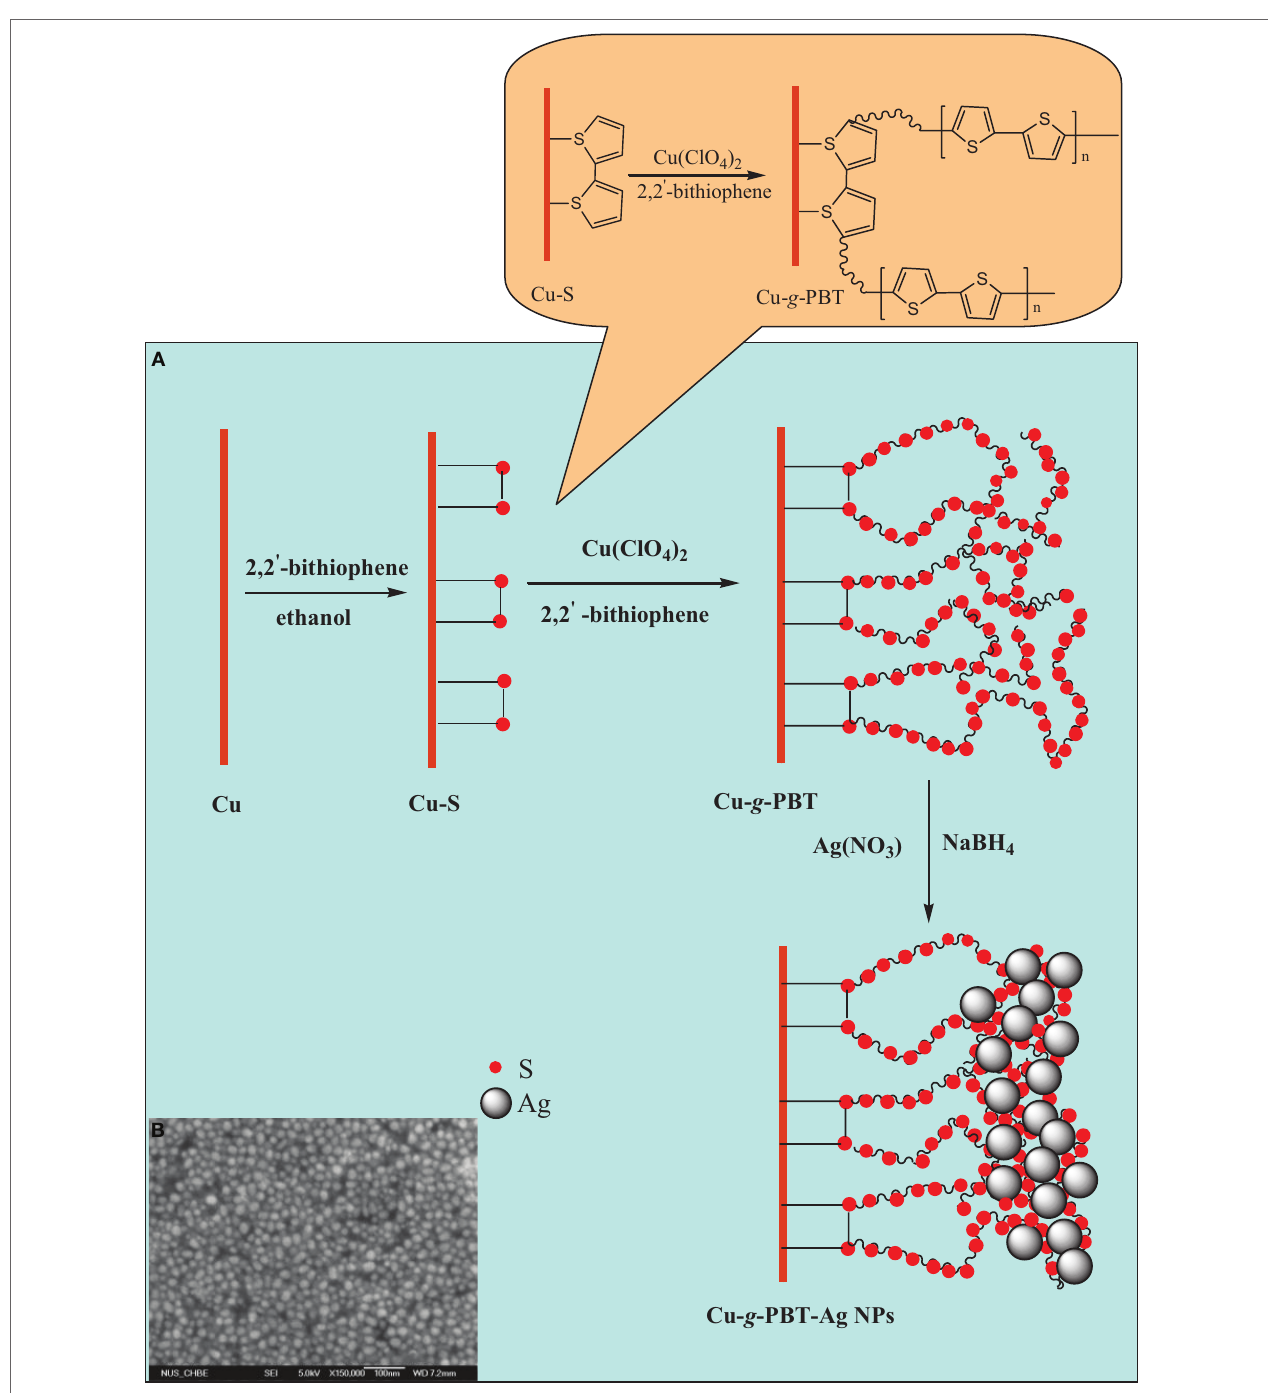
FiGURe 7 | (A) Process of oxidative graft polymerization of 2,2-bithiophene (BT) from the BT monolayer-immobilized copper surface via self-assembly method, and subsequent immobilization of silver nanoparticles (Ag Nps). (B) FESEM images of the Ag Nps-immobilized surface. Reprinted with permission from Videla and Herrera (2009). Copyright 2010 American Chemical